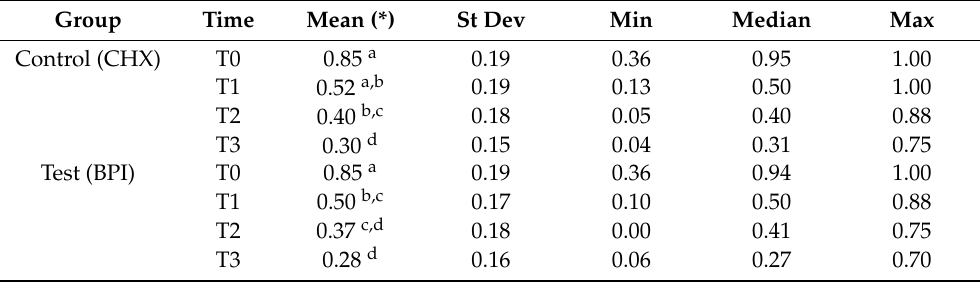
Table 5. Descriptive statistics of the plaque control record